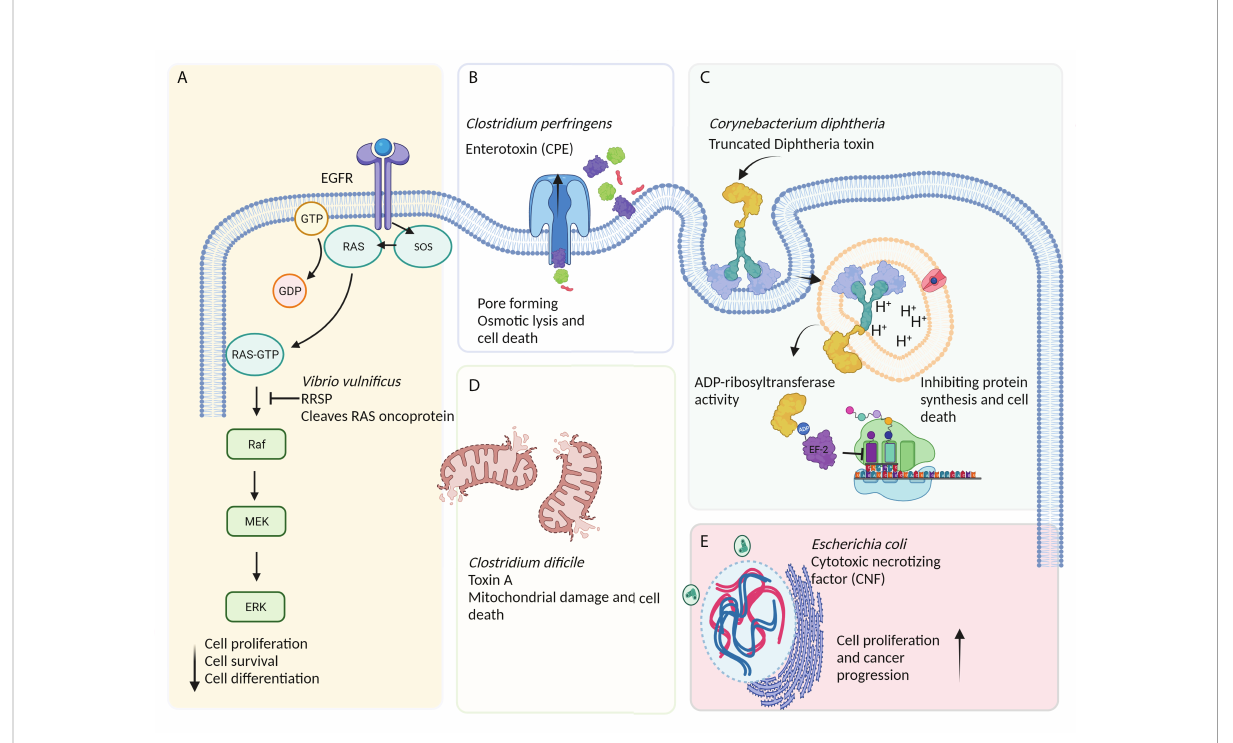
FIGURE 2 The effects of bacteria-derived toxins on cancerous cells. (A) Ras/Rap1-speci fi c endopeptidase (RRSP) toxin secreted by Vibrio vulni fi cus blocks the RAS signal transduction pathway, leading to the abrogation of key signaling modulators (especially Raf) and a reduction in cell proliferation, differentiation, and, ultimately, survival. (B) Apoptosis induced by excessive osmotic pressure caused by the action of pore-forming toxins such as Clostridium perfringens enterotoxin (CPE) and Aeromonas hydrophila aerolysin. (C) The receptor-mediated internalization of diphtheria toxin (DT)-based immunotoxin blocks protein synthesis via inducing the ADP-ribosylation of elongation factor-2 (EF-2), leading to ADP-ribosyl transferase-mediated apoptosis. (D) Other bacterial toxins, such as toxin A (produced by Clostridium dif fi cile ), can induce mitochondria damage and, subsequently, cell death. (E) The cytotoxic necrotizing factor (CNF) is a bacterial single-chain exotoxin produced by Gram-negative bacteria, such as Escherichia coli , and promotes oncogenesis through inducing the activation and proliferation of host cells via a Rho-GTPase- dependent mechanism.